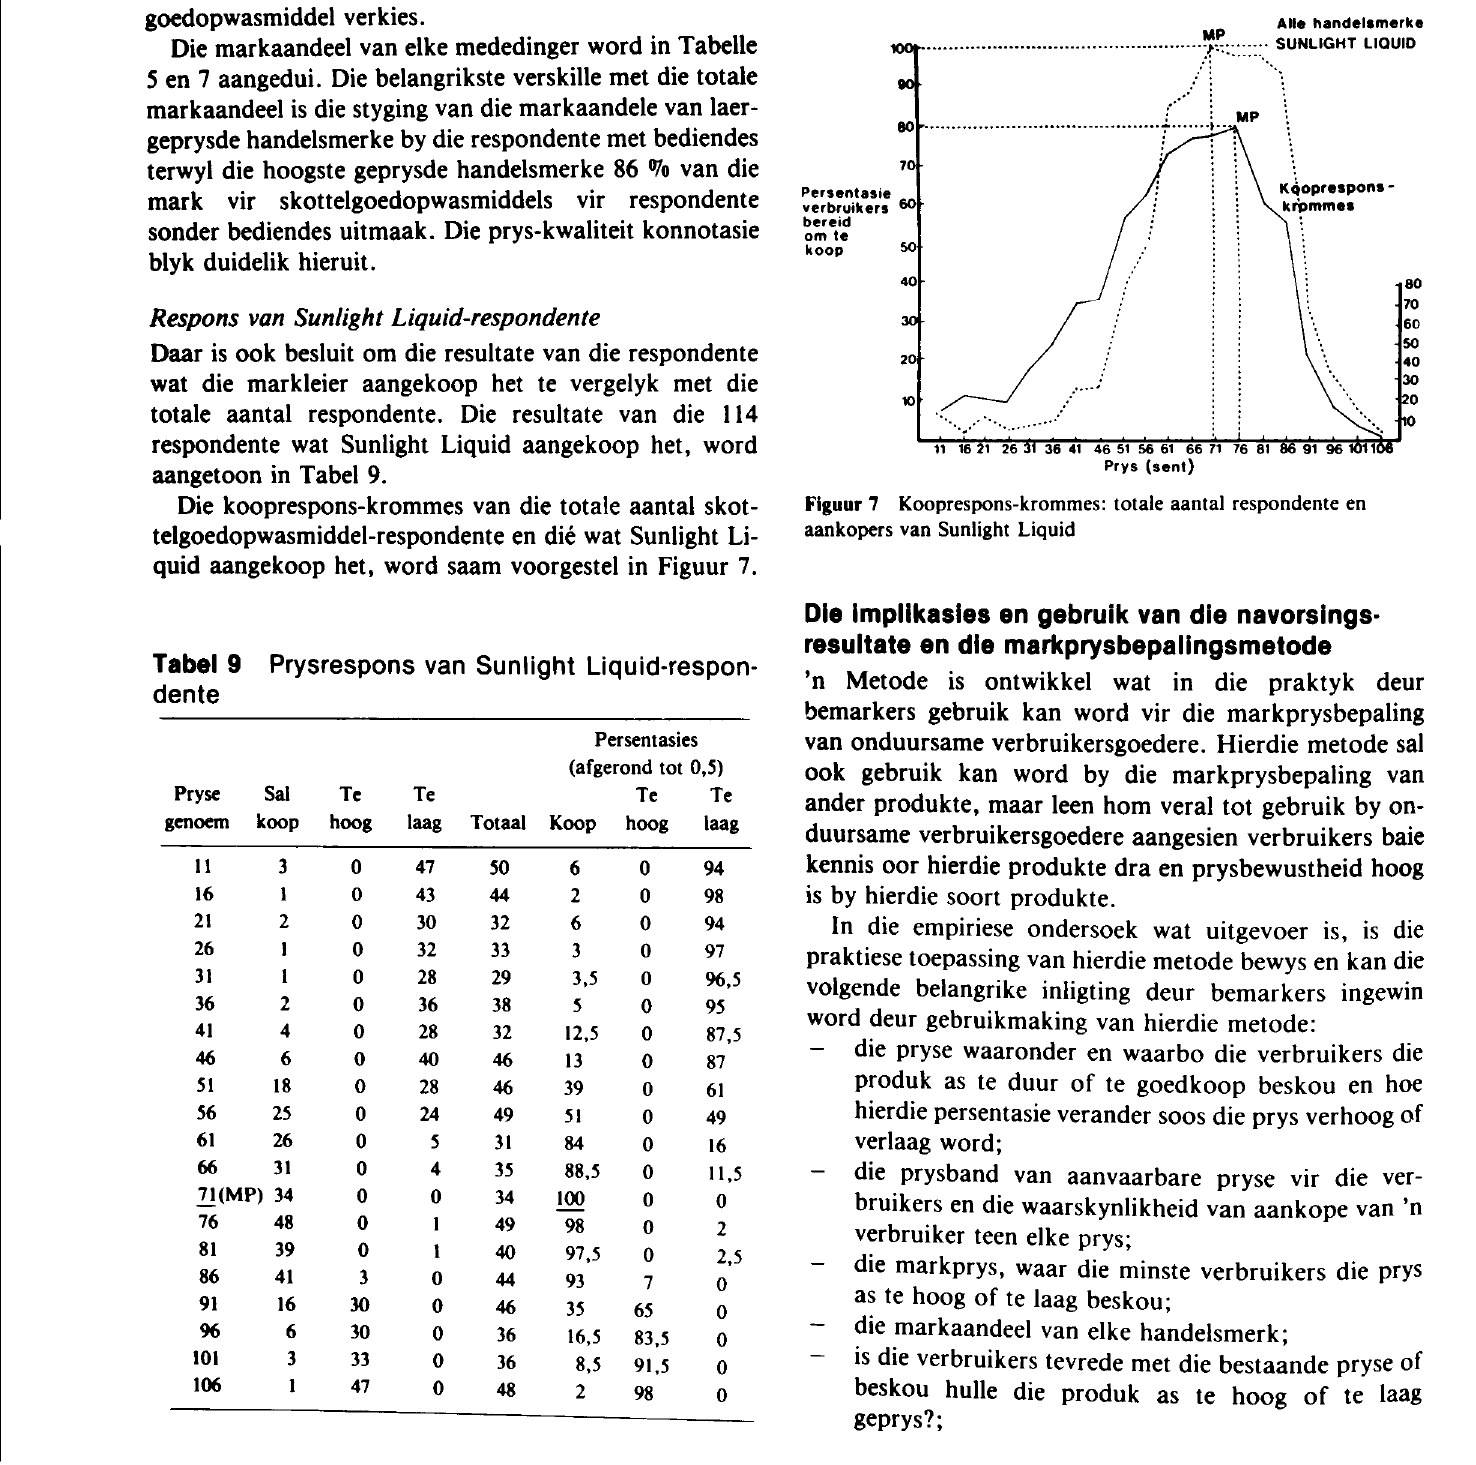
Figuur 7 Kooprespons-krommes: totale aantal respondente en aankopers van Sunlight